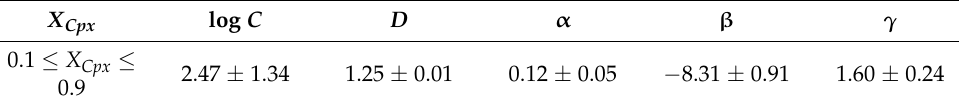
Table 4. Fitting parameters of activation enthalpy and pre-exponential factor for the electrical con- ductivity of dry hot-pressed sintering gabbro with various mineralogical proportions at temperatures of 773–1073 K and 1.0 GPa obtained from σ = CX α pre-exponential factor, the D stands for the activation enthalpy at very small values of X Cpx , X Cpx stands for the volume percentage of clinopyroxene, and all of these parameters including α , β and γ are